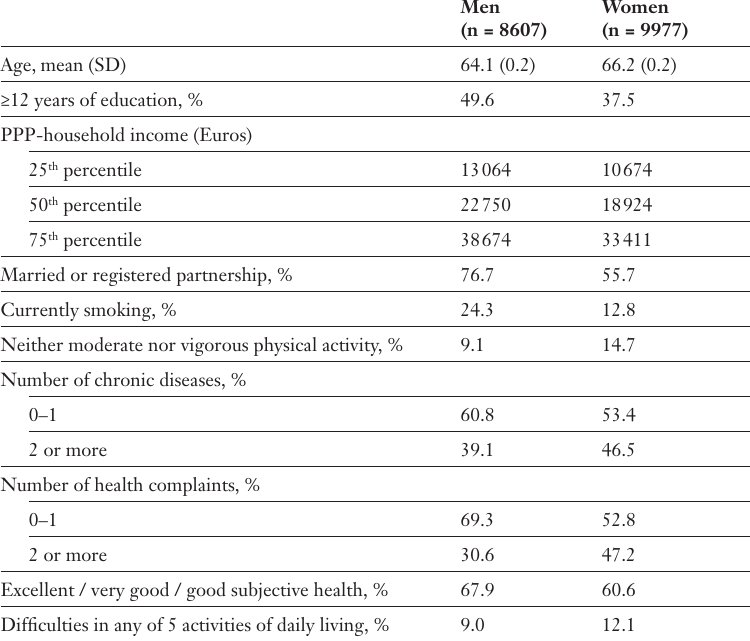
Characteristics of the pooled SHARE study population, by gen- der (weighted